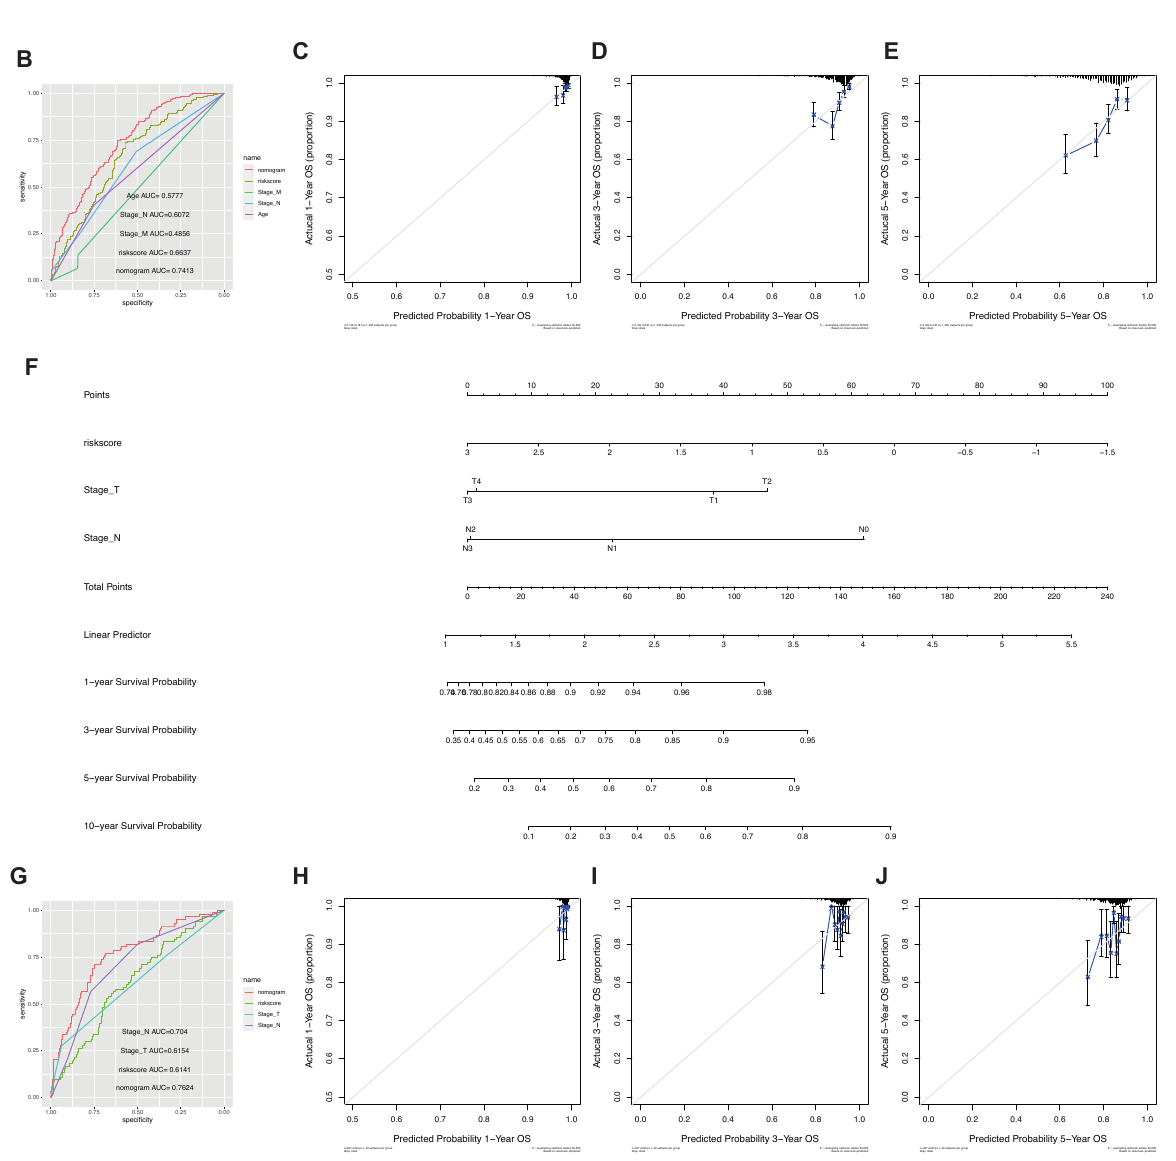
Figure 13. Nomogram and model performance. ( A – E ) TCGA dataset; ( F – J ) GSE20685 dataset. ( A , F ) Nomogram analysis of the predictive power of different clinical indicators and risk score; ( B , G ) ROC curves of different clinical features and risks core predicting OS. Model calibration curves for 1 year ( C , H ), 3 years ( D , I ), and 5 years ( E , J